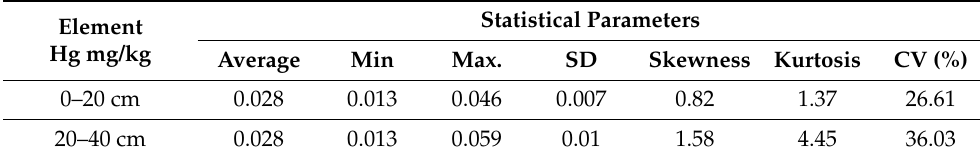
Table 3. Statistical